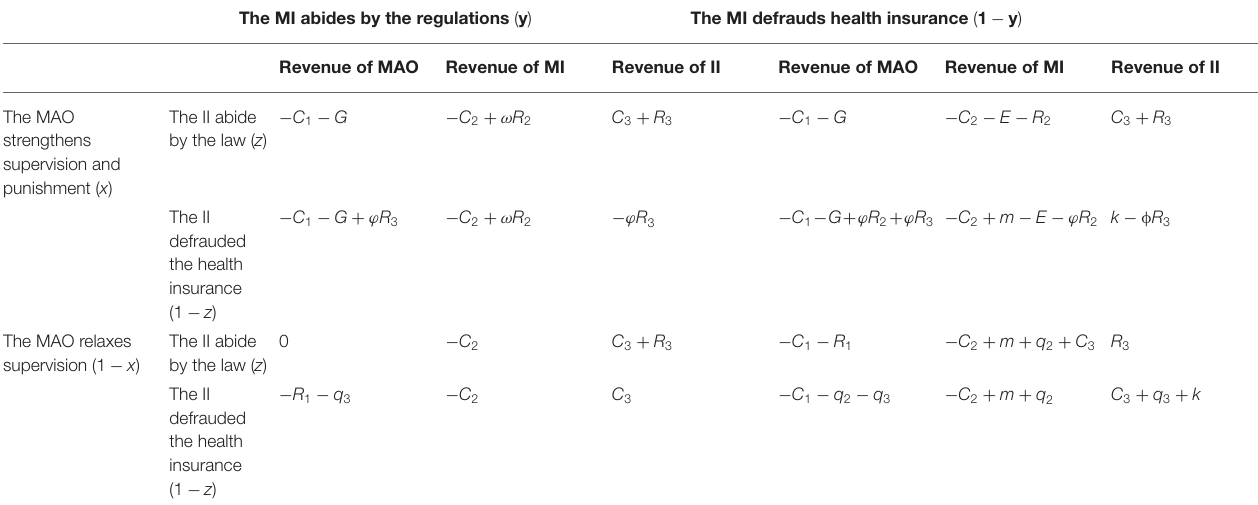
TABLE 2 | Game payment